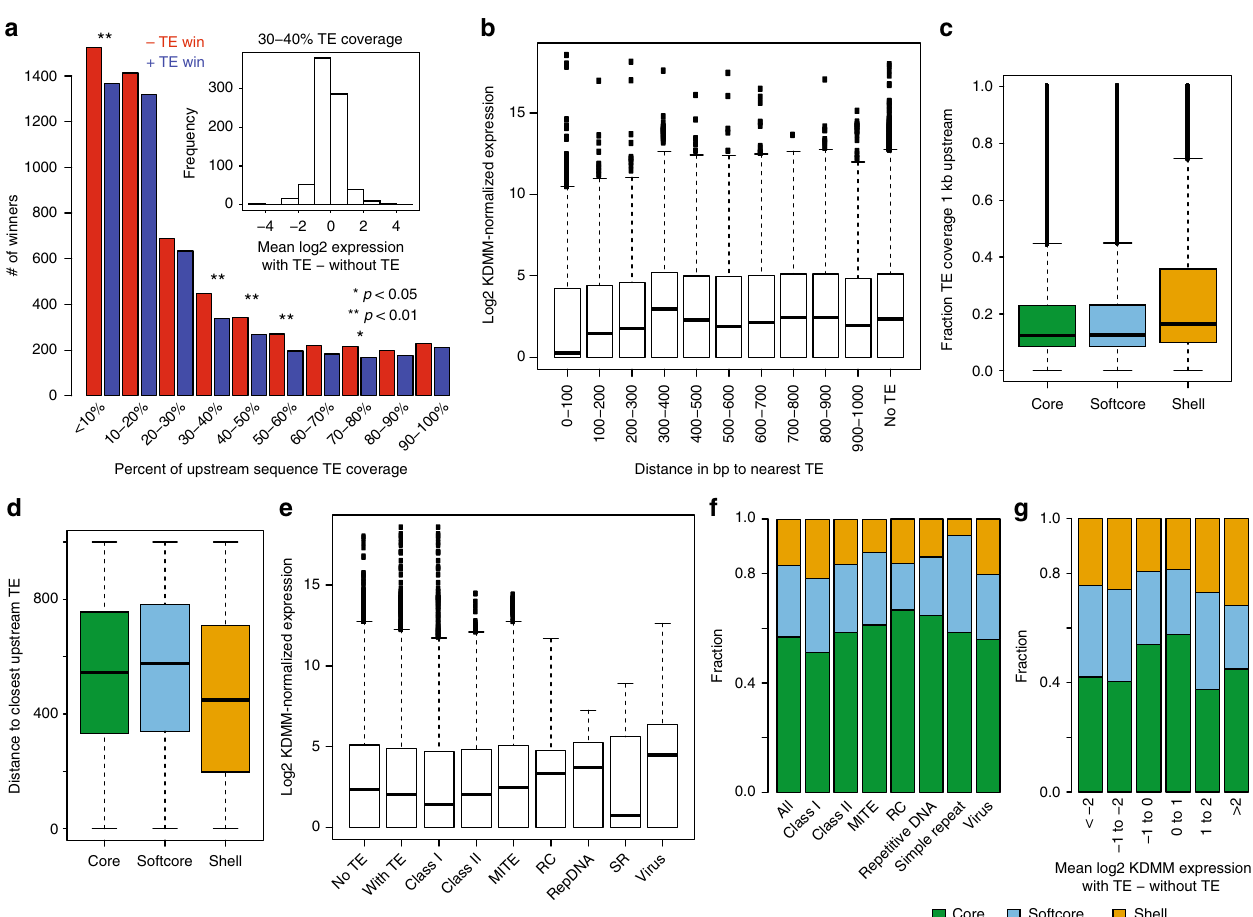
Fig. 6 Effect of TE insertions on gene expression. a Number of winners in binomial distribution sign tests (horserace comparisons) of expression level among alleles with/without TEs, p -values based on a binomial test. Inset shows log2 expression differences between alleles with/without TEs, for focused comparisons of alleles having 30 – 40% TE coverage. b Expression level of genes with TE within speci fi ed distance to the translation start site. c , Fraction of TE coverage of 1 kbp upstream of core, softcore, and shell subsets. d Distance to closest upstream TE for core, softcore, and shell subsets. e Expression level of genes adjacent to respective TE classes. f Percent of genes adjacent to repeats of respective classes assigned as core, softcore, and shell categories. g Genes binned according to mean log2 expression difference between alleles of a gene with/without TEs, each colored according to membership in core, softcore, and shell categories. Whiskers in the above plots extend to the most extreme data point which is no more than 1.5 times the